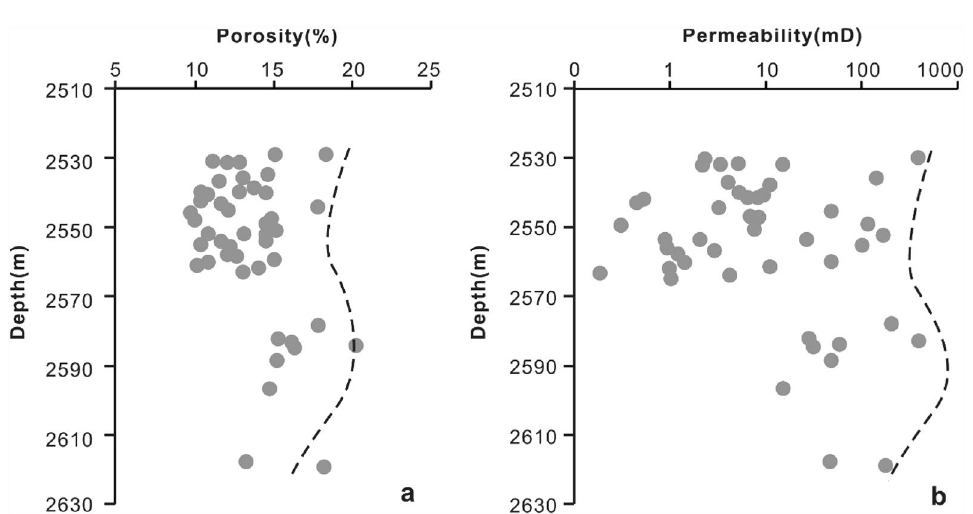
Figure 11. Plot of the depth versus porosity ( a ) and permeability ( b ) for the Miocene ZJ Formation sandstones of Z21 gas field in Huizhou Depression. The porosity and permeability are collected from Shenzhen Branch of CNOOC (China National Offshore Oil